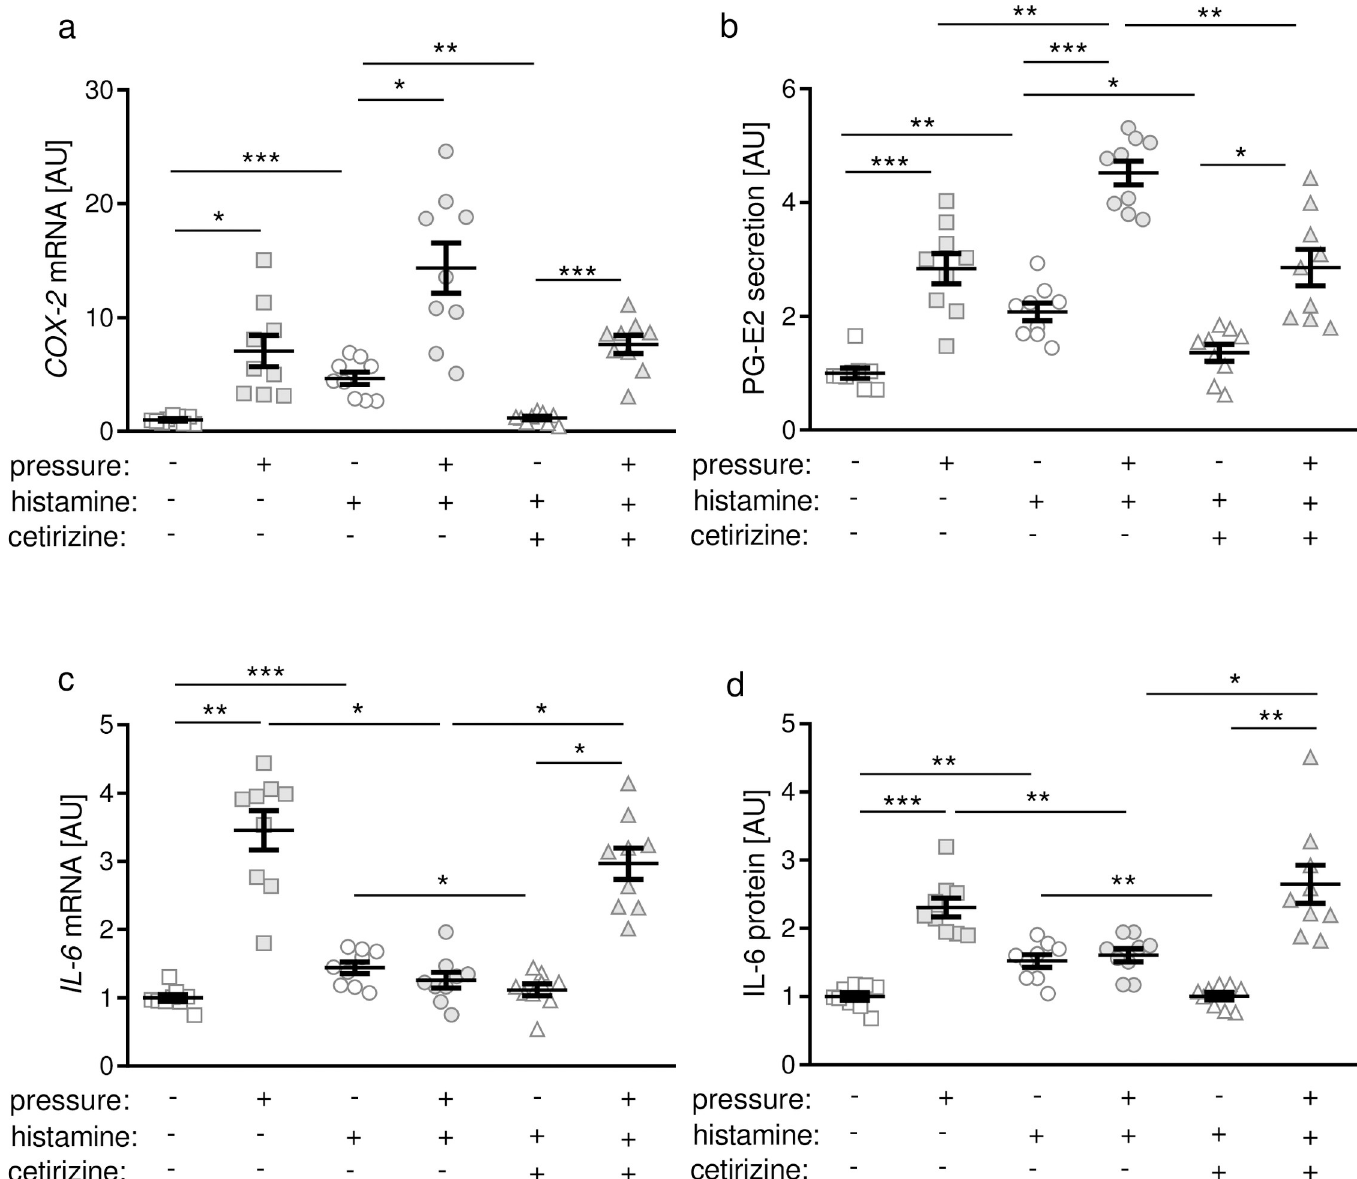
Fig 4. COX-2 gene expression (a), PG-E2 secretion (b), IL-6 gene expression (c) and IL-6 secretion (d) after compression with or without histamine or inhibition with cetirizine. AU: arbitrary units; � p � 0.05; �� p � 0.01; ��� p � 0.001. Statistics: Welch-corrected ANOVA with Games-Howell posthoc tests. Each symbol in figures represents a data point. Horizontal lines represent the mean ± standard error of mean.